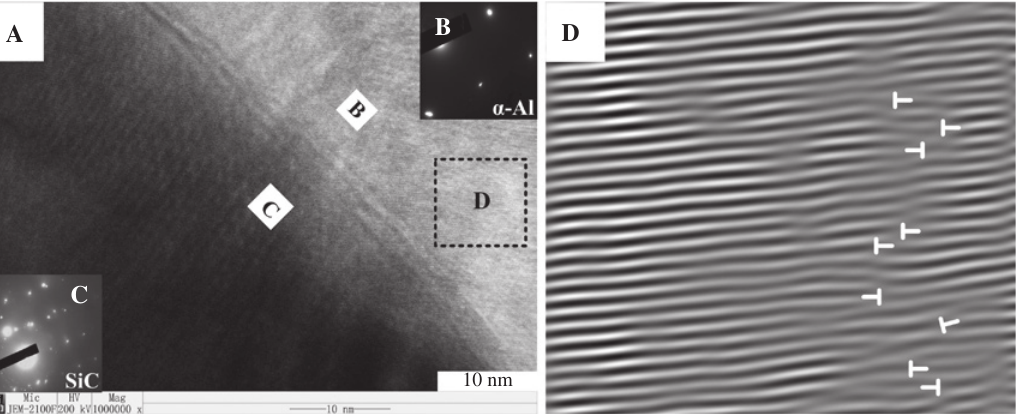
/Al2014 composites, p